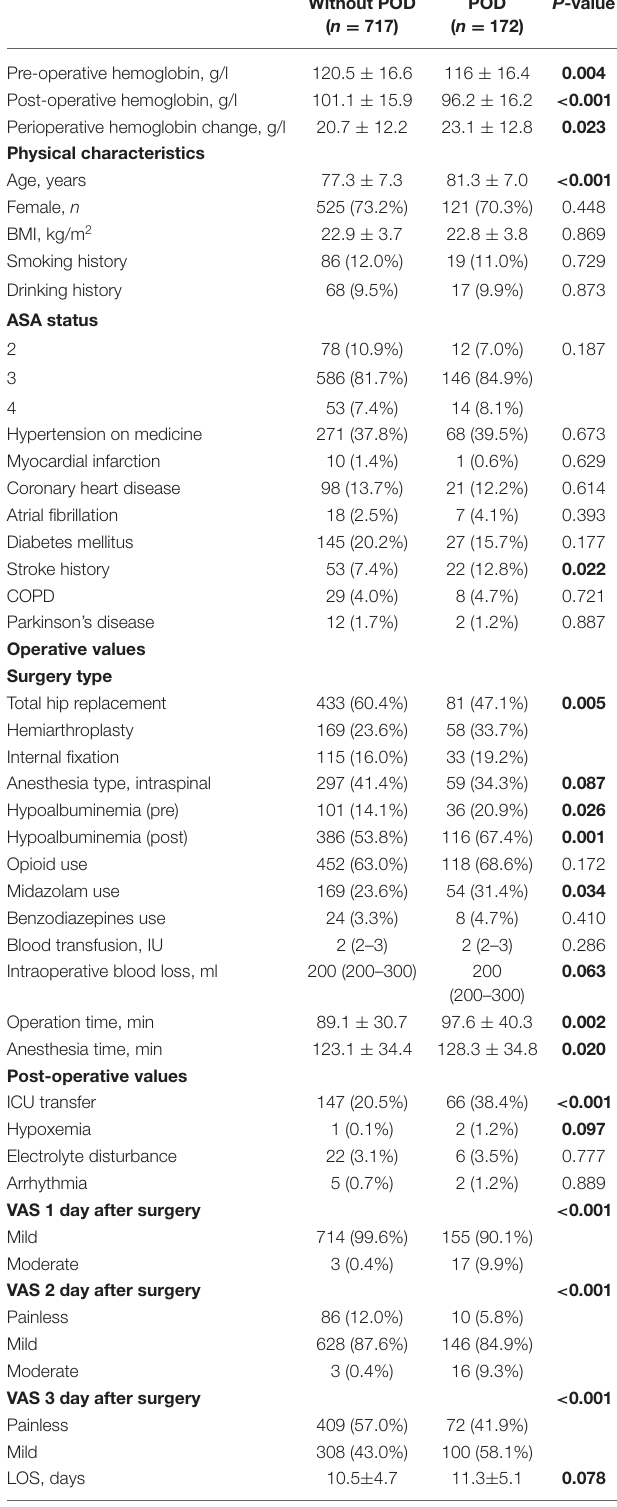
TABLE 1 | The time of post-operative delirium happening from surgery end. Days after surgery 0 1st